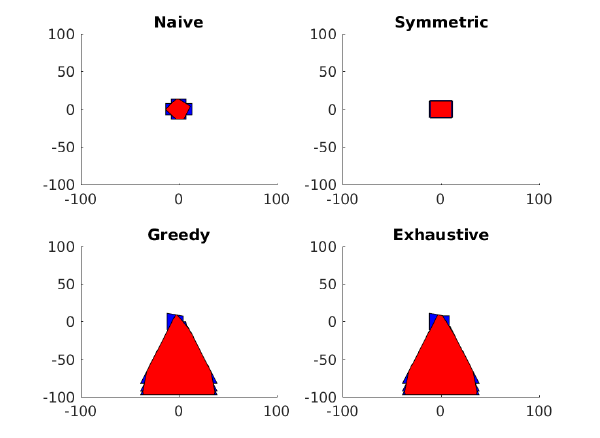
Figure 11. The resulting field of view when optimizing for maximal convex region rather than maximum total area. Blue represents the camera FoV and red represents the found convex